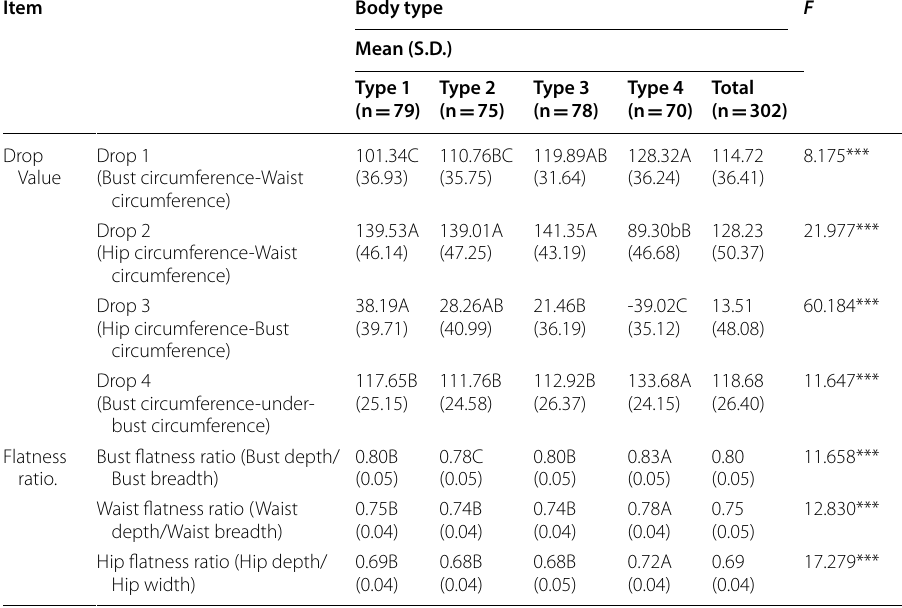
Alphabet is the result of Duncan’s post hoc test (A > B >